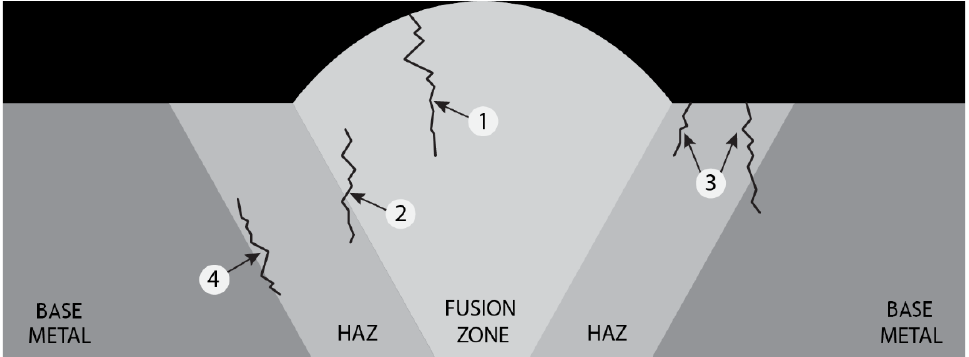
Figure 15. Optical image of untempered martensite in the HAZ of AISI